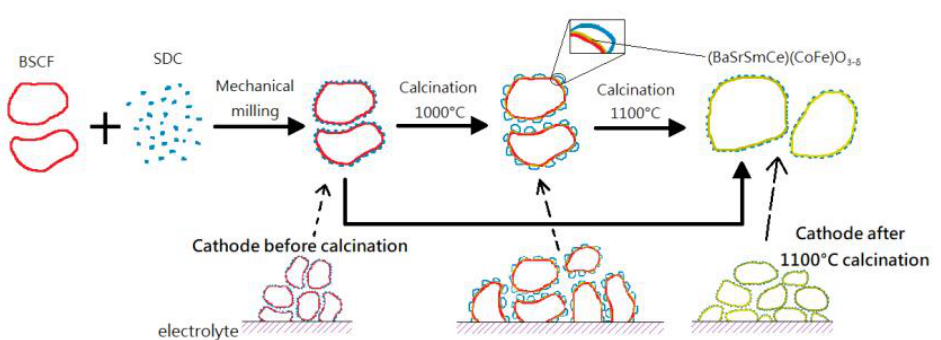
Figure 6. Schematic diagram for the sintering mechanism of BSCF + SDC composite cathode, redrawn from